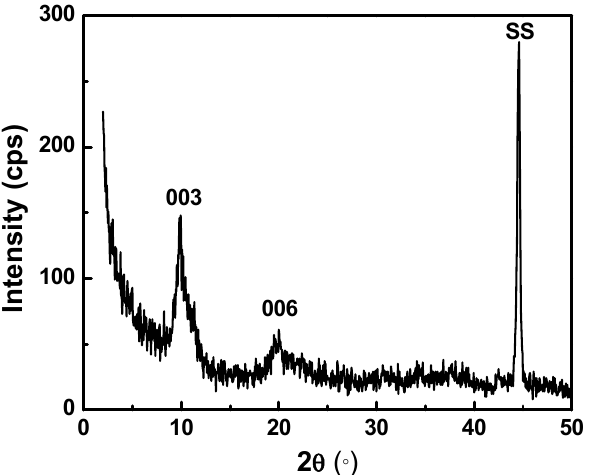
Figure 1. X-ray diffraction pattern of an electrodeposited modified zaccagnaite coating on stainless steel (SS) substrate.